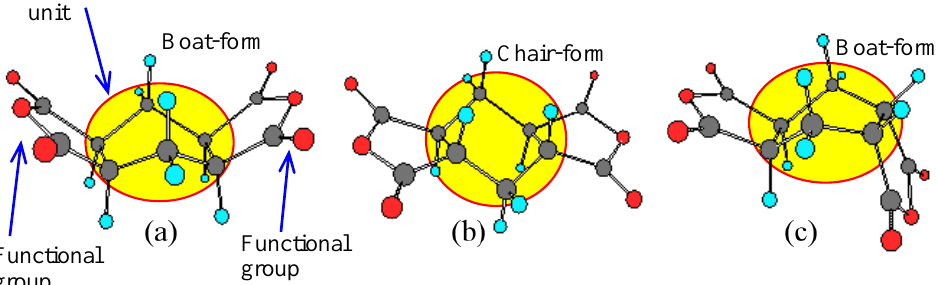
Figure 13. The steric structures of three isomers of hydrogenated PMDA as determined by single-crystal X-ray diffraction method: ( a ) H-PMDA, ( b ) H′-PMDA, ( c ) H″-PMDA. Reproduced with permission from Elsevier [37].